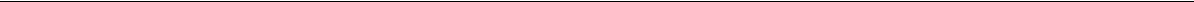
Figure 3 | Characterization of monocyte and macrophage biology in a unique QKI haploinsufficient patient. ( a ) Schematic of chromosomal translocation event in the qkI haploinsufficient patient (Pat- QKI þ / (cid:2) ), reducing QKI expression to B 50% that of her sister control (Sib- QKI þ / þ ). ( b ) Top: UCSC Genome Browser display of reference genome QKI locus with standard and chimeric reads for the patient and sibling. The reduced expression levels and altered 3 0 -untranslated region (UTR) composition in the patient RNA as compared with a sibling control is noteworthy. Patient shows increased intronic RNA extending to the point where chimeric reads map at the breakpoint to chr5. Middle: chromosome diagrams showing normal chromosomes 5 and 6 with the red line, indicating the location of the breakage fusion point. Bottom: sequence across the fusion point. The chromosomal origin of the AG dinucleotide is ambiguous. ( c ) Photomicrographs of sibling and patient macrophages, cultured in GM-CSF or M-CSF for 7 days, respectively. ( d , e ) Assessment of QKI isoform mRNA and protein expression in 4-day GM-CSF-stimulated macrophages in the sibling and patient. ( f ) Hierarchical clustering (Euclidean algorithm) of key monocyte differentiation genes depicting changes in RNA-seq-derived mRNA abundance where dark blue ¼ low expression, whereas light blue ¼ high expression (* and/or # indicates Z 1.5-fold expression change in monocytes or macrophages, respectively). ( g ) Venn diagrams with numbers of differentially expressed genes (minimally ± 1.5-fold; patient/sibling expression) for unstimulated (top) and GM-CSF stimulated macrophages (bottom). An expression cutoff (Pat þ Sib expression Z 1CPM) was applied. ( h ) The most differentially expressed genes, harbouring a QRE are depicted. ( i ) Genome-wide scatterplot of mRNA abundance ( y axis: Log 10 CPM) versus the log 2 FC ( x axis: Patient/sibling CPM) after an expression cutoff (Pat þ Sib expression Z 1 CPM) in monocytes (left) and GM-CSF-stimulated macrophages (right). Blue dots indicate QRE-containing transcripts minimally ± 1.5-fold differentially expressed. Grey dots do not fulfill these criteria. ( j ) CDF ( y axis) for QKI target (QRE containing: blue line) and non-target (non-QRE containing: cyan line) mRNAs ( x axis: log 2 FC) in monocytes (left) and macrophages (right). Left shift indicates lower expression of QKI target genes, whereas a right shift indicates higher expression of QKI targets in the patient samples. Distributions were compared using a Wilcoxon rank-sum